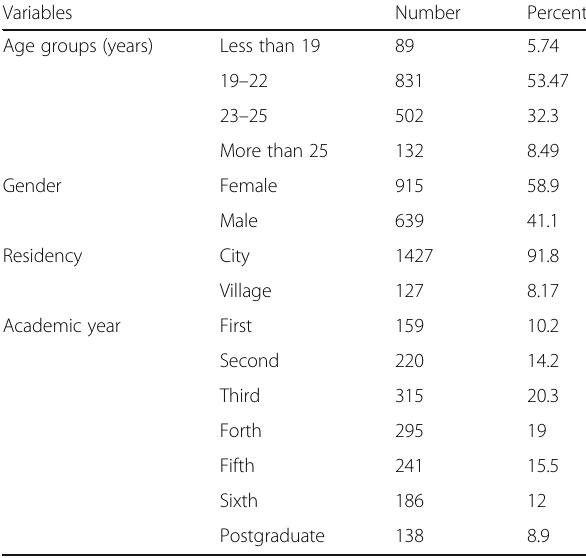
Table 1 Background characteristic ( n =